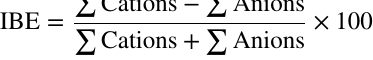
Table 1 Chemical composition of groundwater